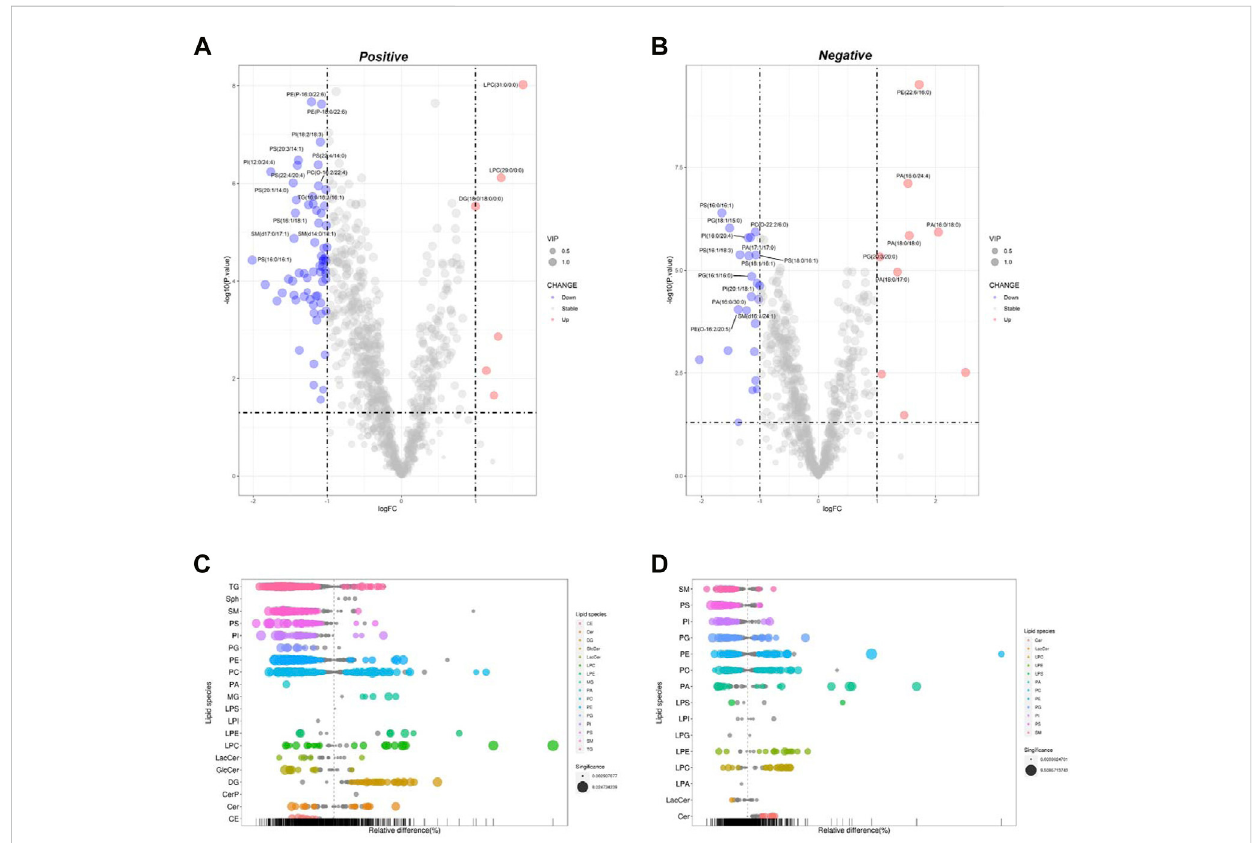
FIGURE 3 Analysis of signi fi cantly differential lipid substances in the Pal + Cel group versus the Pal group. Volcano plots (A,B) and lipid plots (C,D) in both positiveandnegativeionmodes,respectively.Inthevolcanoplot,lipidspecieswerescreenedoutbasedonthecriteriaof p < 0.05,VIP ≥ 1,andfoldchange < 0.5 or >